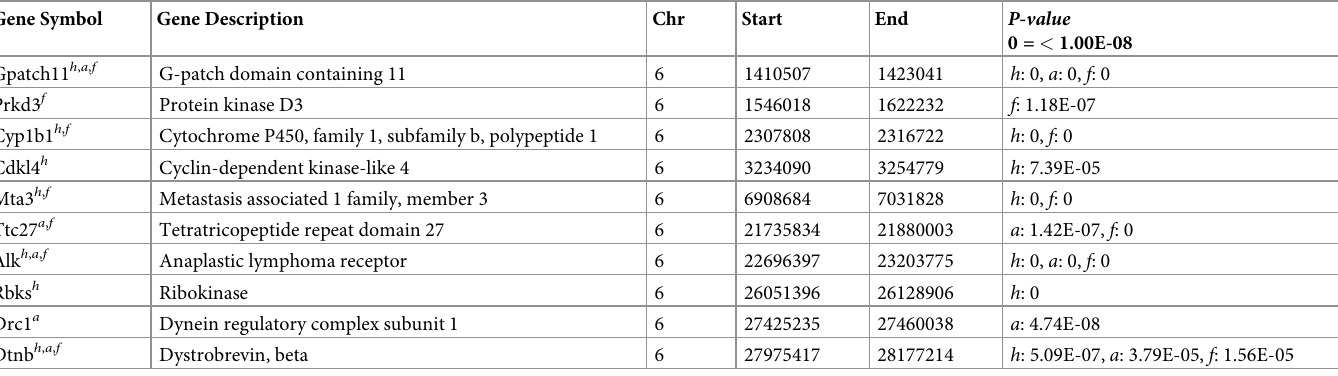
Table 2. Differentially expressed genes within the Stresp10 QTL region containing coding region non-synonymous SNPs between F344 and